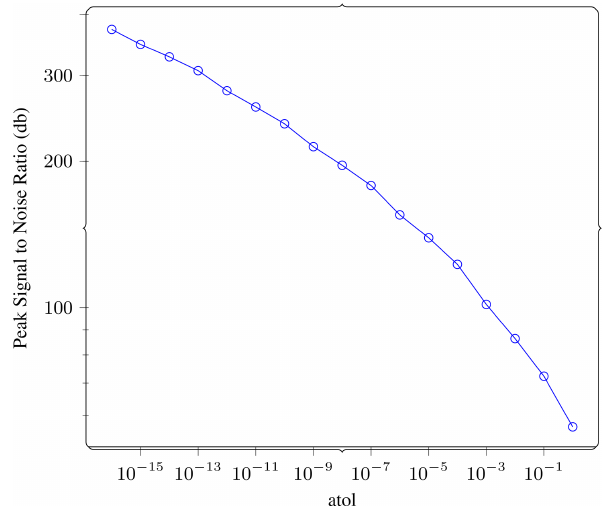
Figure 7. Direct compression. We compress the wave field at the last time step of the reference solution using different absolute error tolerance ( atol ) settings and report the peak signal-to-noise ratio (PSNR) achieved. Higher PSNR is lower error. The PSNR is very high for low atol and drops predictably as atol is increased. See Fig. A1 for more metrics on this